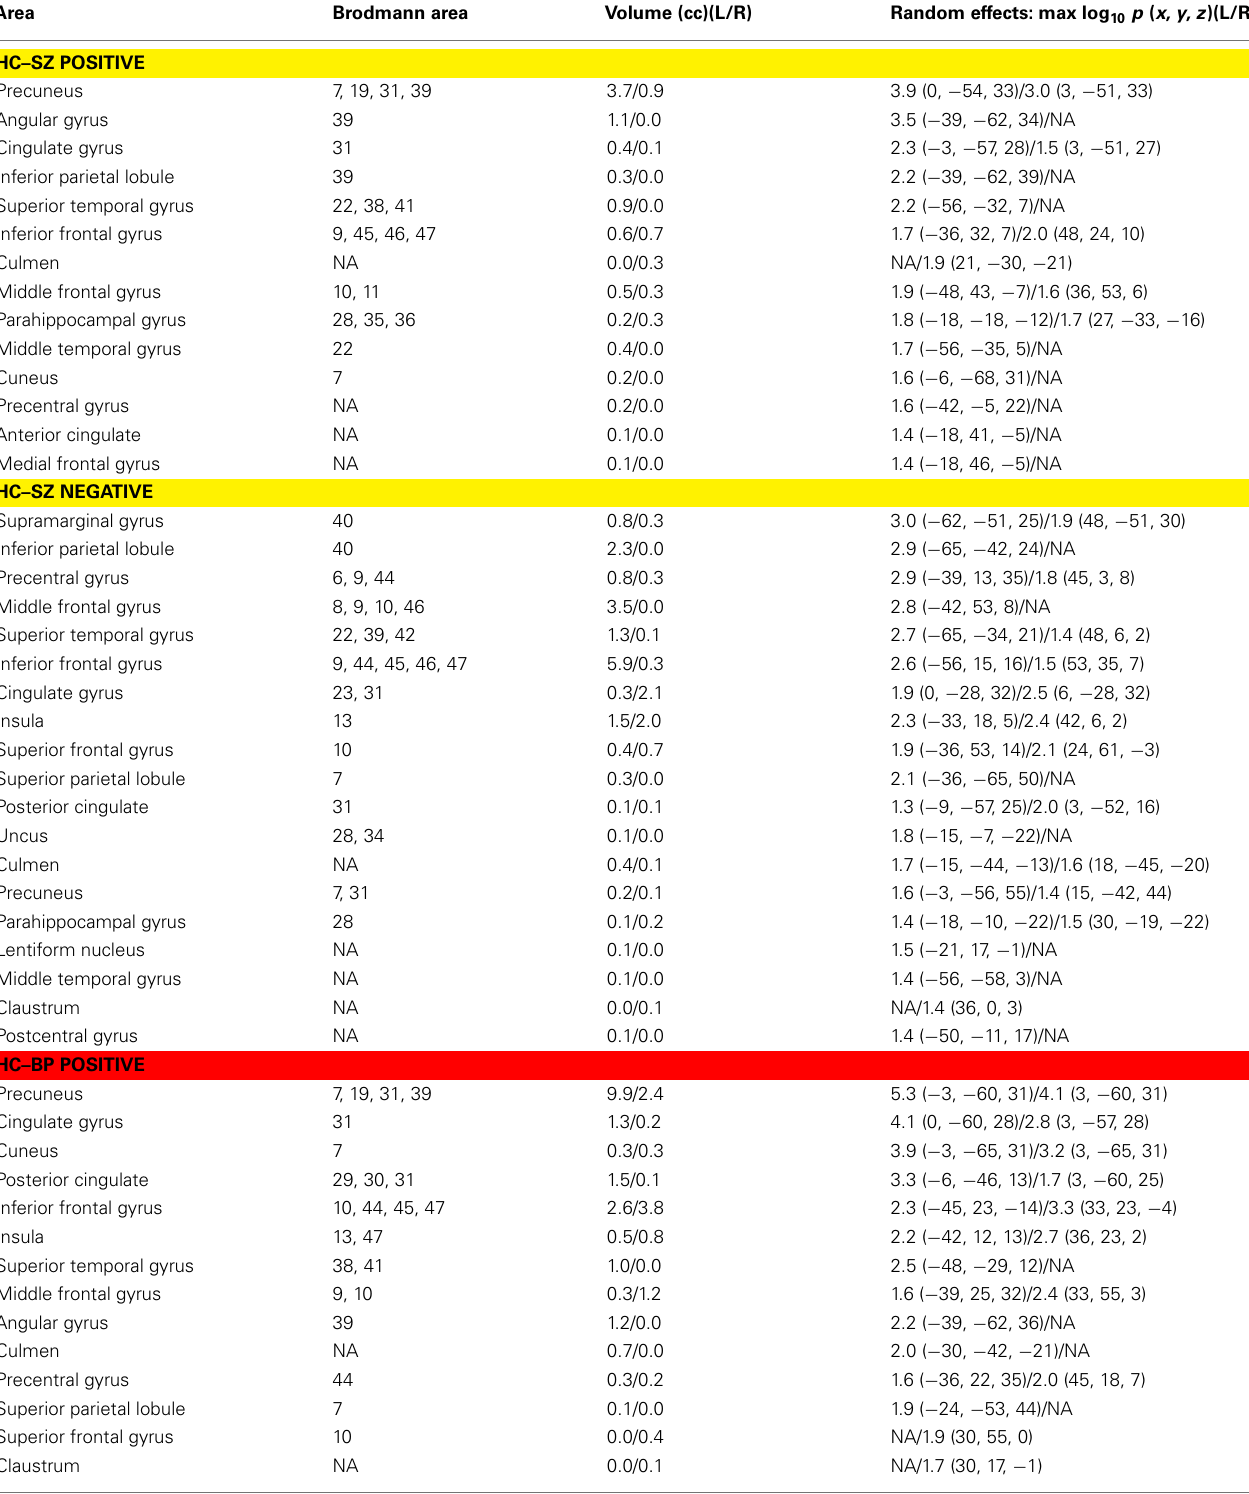
Table 2 | Summary of regions showing group differences in spatial maps: clusters of significant between-group differences (cluster size > 27 voxels; p < 0.05 corrected for multiple comparisons within each component) from components C55, C38, C43, C30, C25, and C42 (which are displayed in Figure